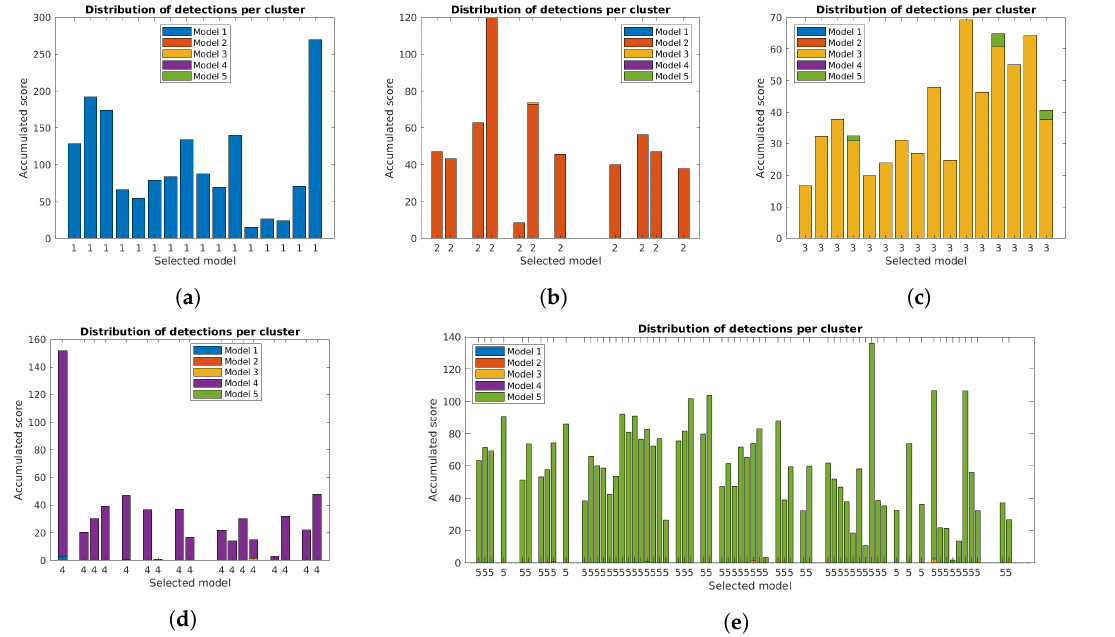
Figure 11. Accumulated scores for each lamp model in each cluster of the five case studies for the unconstrained system [31]. The model corresponding to the highest value is included below each bar: ( a – e ) Case studies 1 to 5.